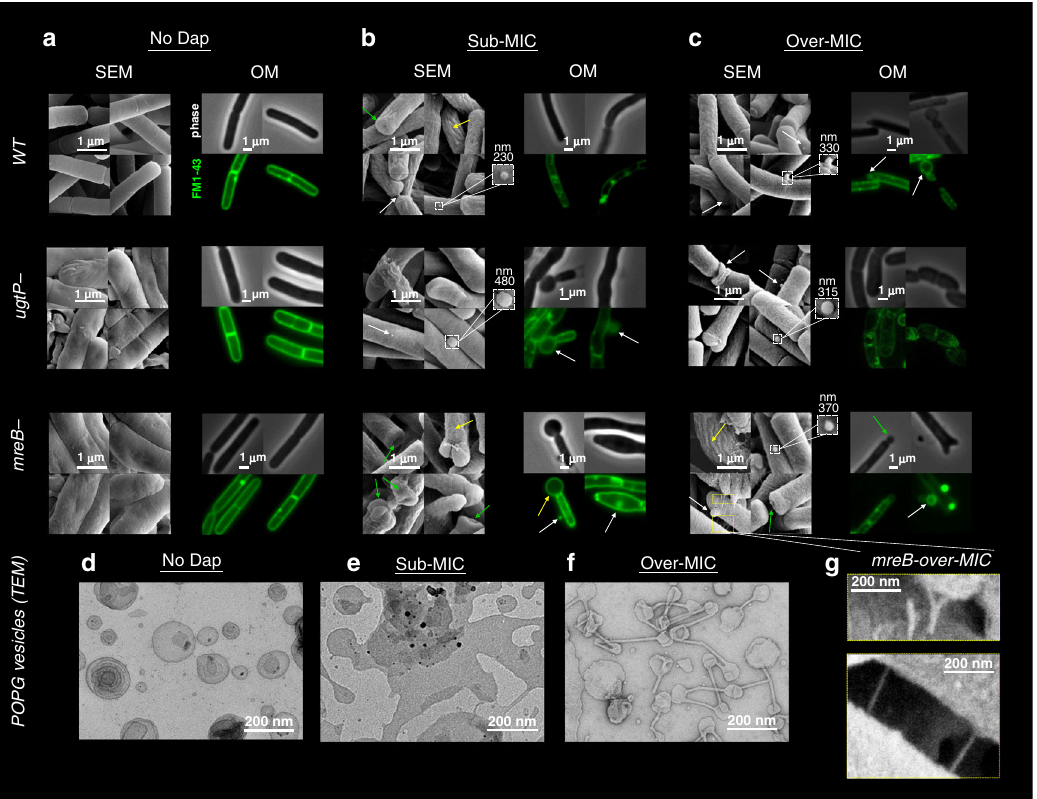
Fig. 1 Dap action on B. subtilis strains (WT, Δ mreB and Δ ugtP strains) and on POPG vesicles by EM and OM. a In the absence of Dap, the Δ mreB and Δ ugtP mutant strains display abnormal surfaces visible by SEM, whereas the OM does not display such disparities. b Exposed for 15 min to sub-MIC Dap, SEM displays in the WT and Δ mreB strains, but not in the Δ ugtP strain, the creasing of the bacterial cell wall surface (yellow arrows). In all the strains, we observe pronounced deformations at the cell poles (green arrow) and submicron protuberances emerging, seemly of lipidic nature given its spherical shape (white arrow and insets). In contrast, the OM displays bulbous micron-sized swellings, primarily coming out of the bacterial poles in the two mutants, but not in the WT cells. Thus, the cell wall delimits the Dap-induced morphological alterations. c Exposed for 15 min to over-MIC, the OM also displays bulbous micron-sized swellings in the WT B. subtilis . All the rest of deformations observed at sub-MIC are found also at over-MIC in all the strains. d – f TEM of POPG vesicles exposed to Dap: In the absence of Dap, the POPG vesicles display spherical shape; at sub-MIC, a number of tubulations emerge from, and interconnect, the vesicles (black arrows); at over-MIC, the tubulations are omnipresent interconnecting the vesicles and the surface of the vesicles becomes creased. g Detail of the tubulations that appear in the Δ mreB cells at over-MIC visualised by SEM. Their size, shape, and interconnective character, is comparable to those observed in POPG vesicles shown in e and f . These tubules are only noticed with Δ mreB mutant; thus, they are not created by the SEM sample